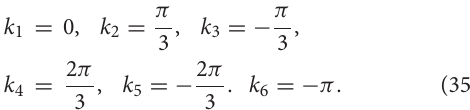
excited mainly by the one-body operator a + Since the s.p. states are partially occupied, the h–h and